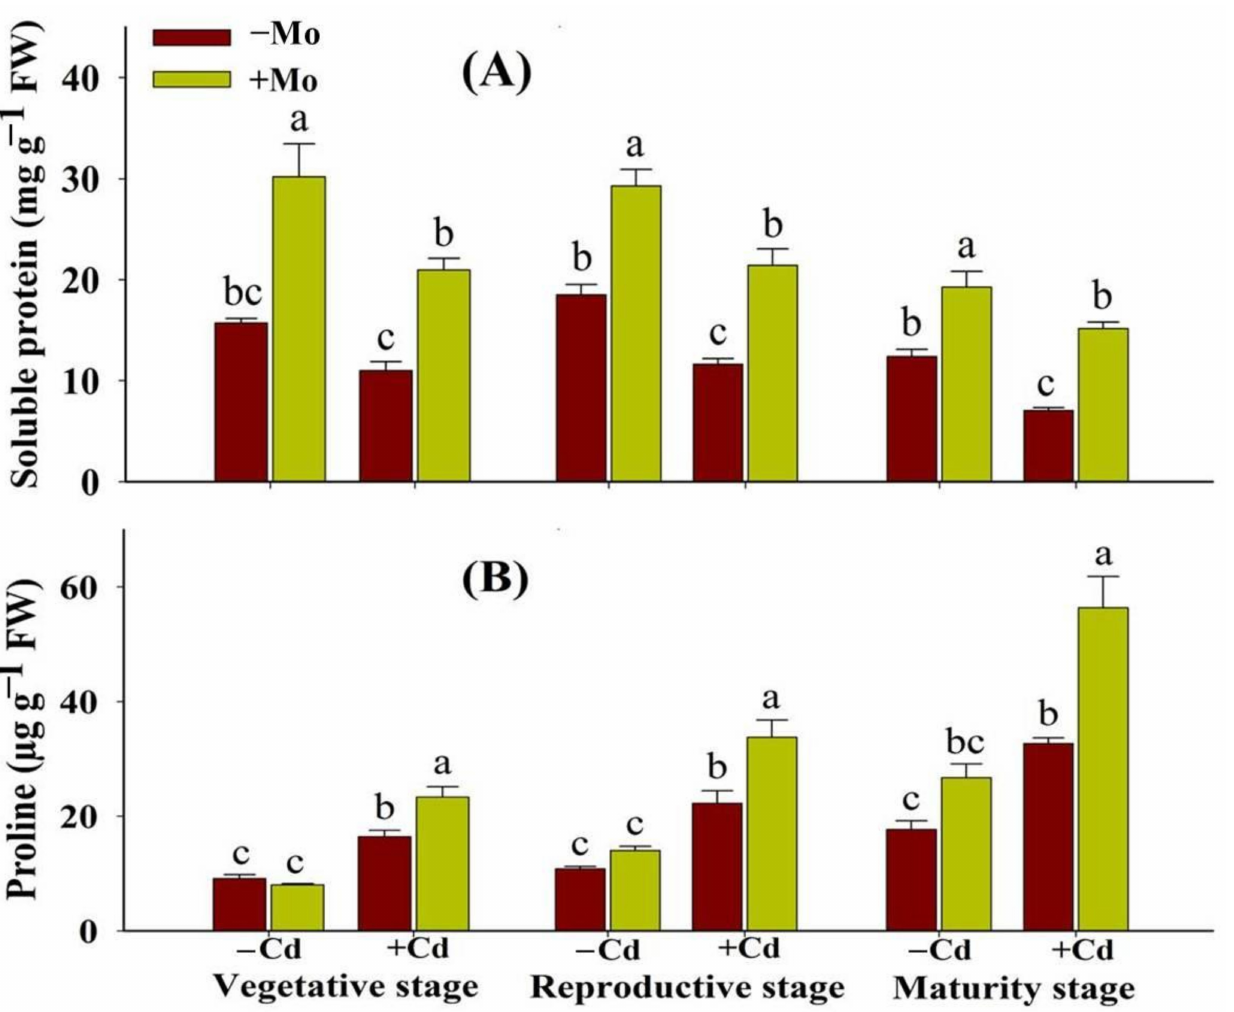
Figure 3. Effect of Mo supply and Cd toxicity on soluble protein ( A ) and proline contents ( B ) in leaves of aromatic rice ‘Xiangyaxiangzhan’ cultivar, at the vegetative, reproductive, and maturity stages. Bars above means indicate ± S.E. of four independent replicates ( n = 4) and different small alphabetical letters above means reveal significant differences among treatments within a particular growth stage according to the LSD test ( p <